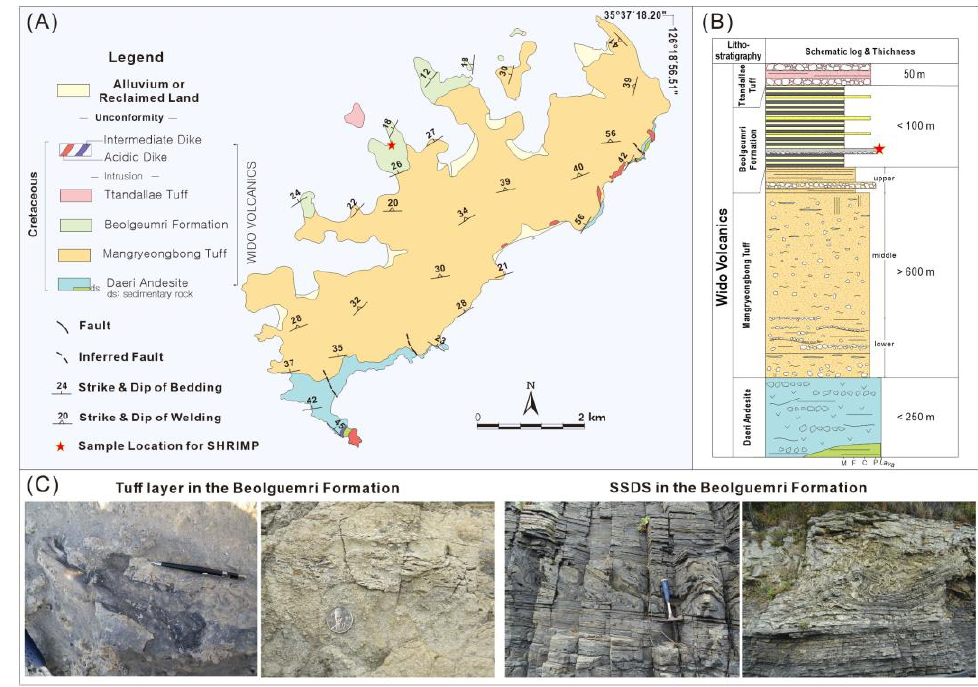
Figure 2. ( A ) Geological map of the Wido Volcanics (modified after [28]), ( B ) Schematic log of the volcano-sedimentary succession in the Wido Volcanics (modified after [12]), ( C ) Outcrop photographs of tuff layer and soft sediment deformation structures (SSDS) in the Beolgeumri Formation.